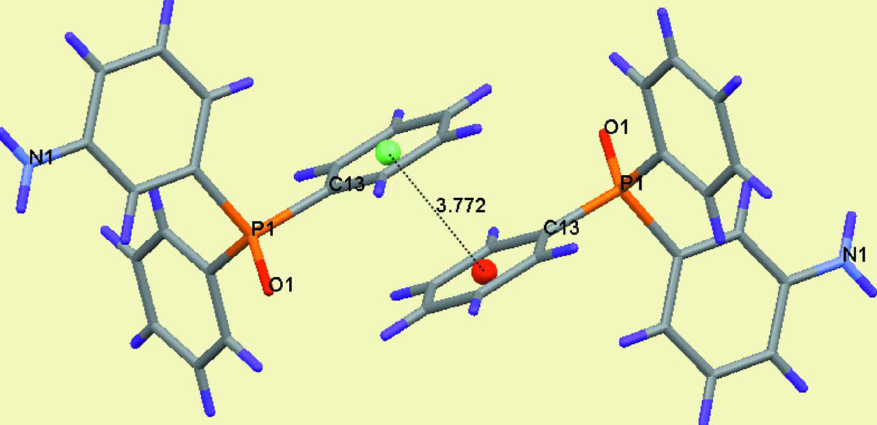
Figure 3 π - π Stacking interactions between aromatic rings of phenyl rings with distance of 3.7720 (15) Å [1 - x , 2 - y , - z